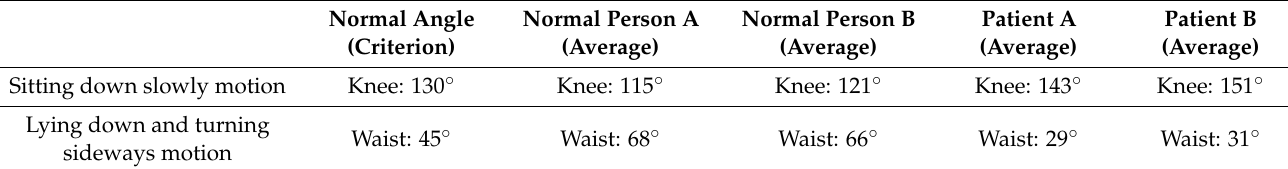
Table 4. Test criteria and average angle of each test